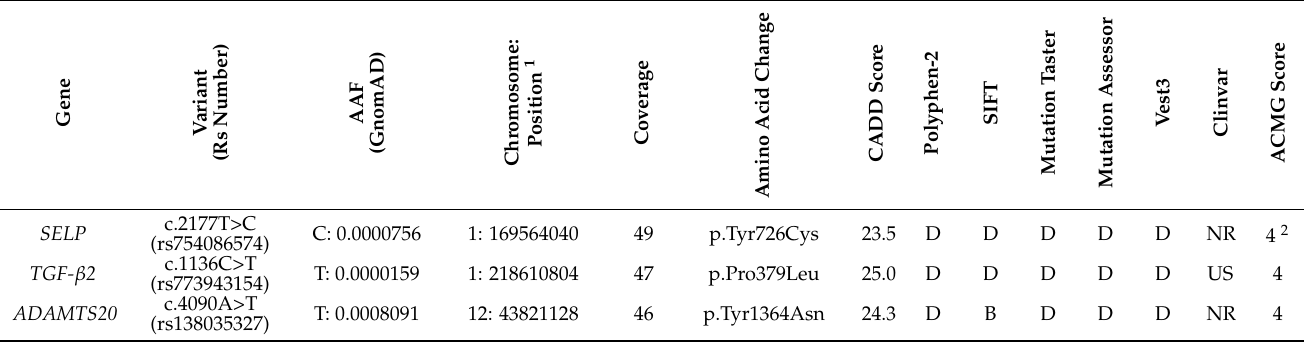
Table 3. Summary of the three shortlisted risk variants following